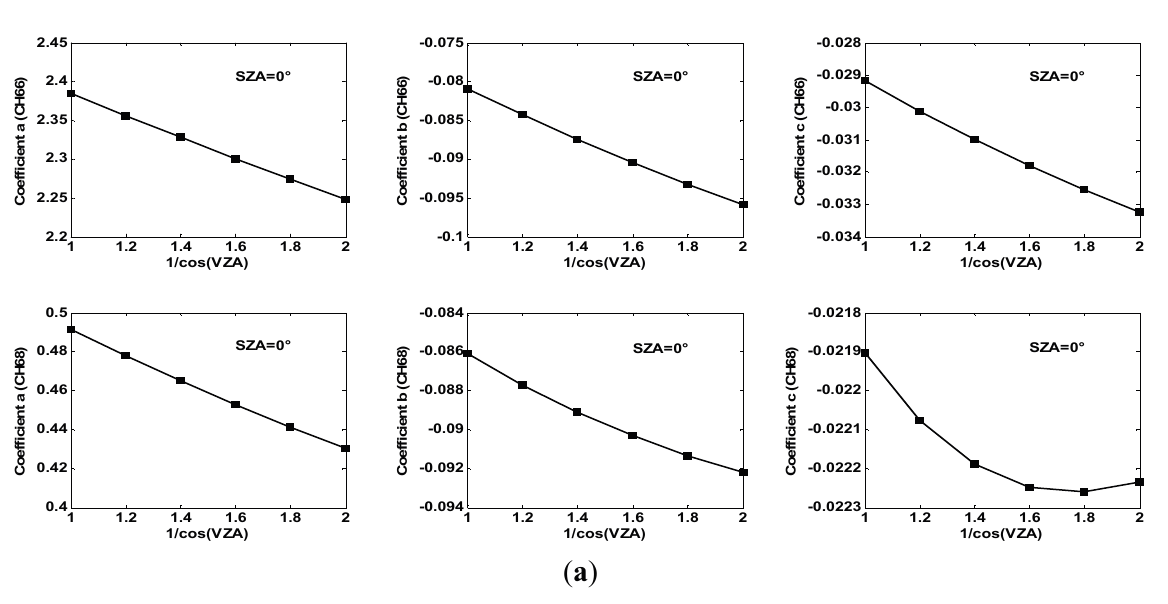
Figure 2. Relationships between coefficients a , b , c and 1/cos(VZA) . ( a ) SZA = 0°. ( b ) SZA = 60°.